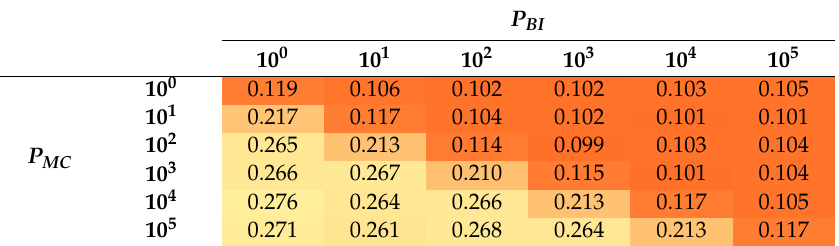
Figure 3. Two sets of the study network layouts generated in Phase 1 (low and high branched index (BI)): ( a ) BI = 0.41, meshedness coefficient (MC) = 0.2; ( b ) BI = 0.4, MC = 0.4; ( c ) BI = 0.81, MC = 0.29; and ( d ) BI = 0.81, MC = 0.4. Table 2. Averaged absolute errors of the branch index (BI) for different penalty factors.